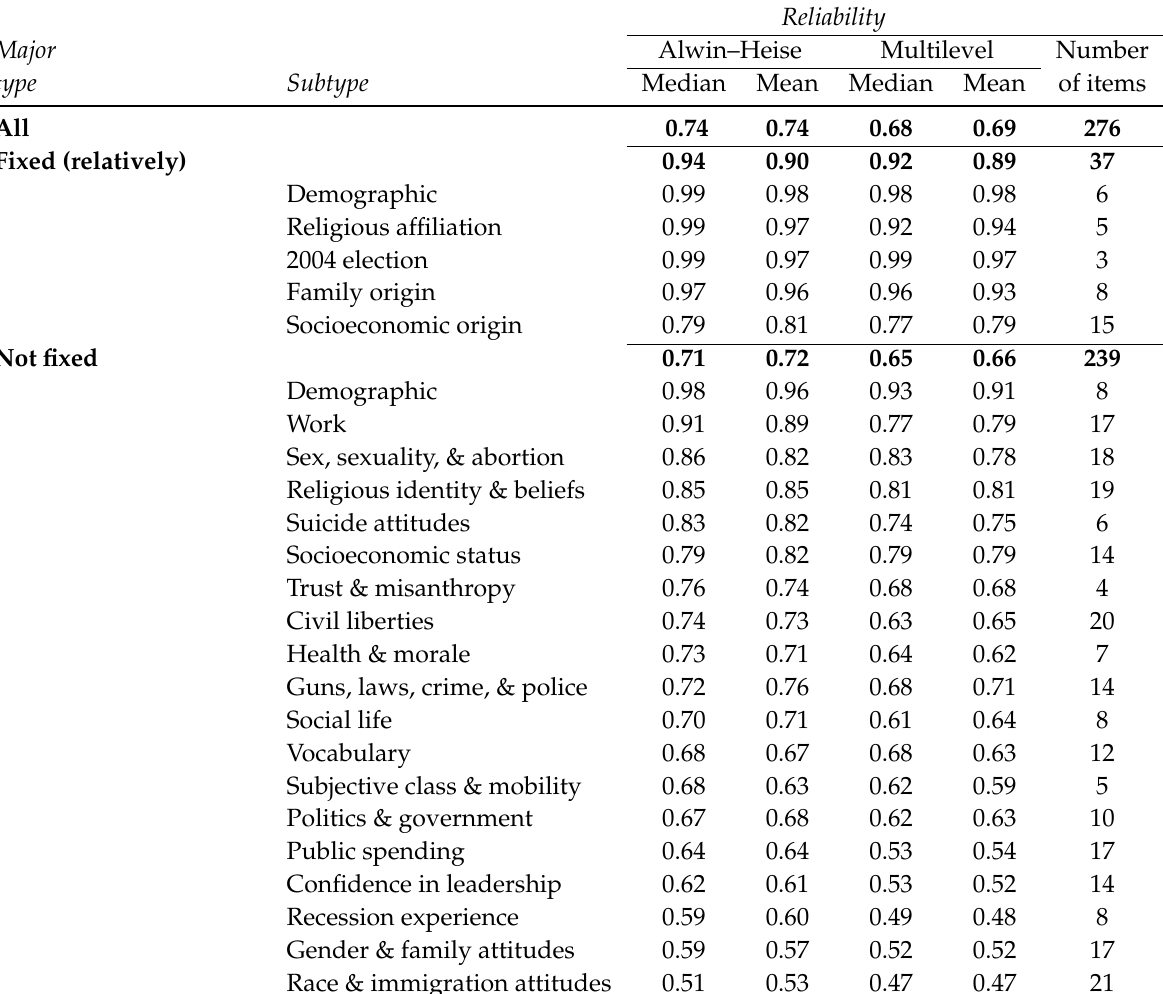
Table 2: Summary statistics for reliability estimates by major type and subtype of